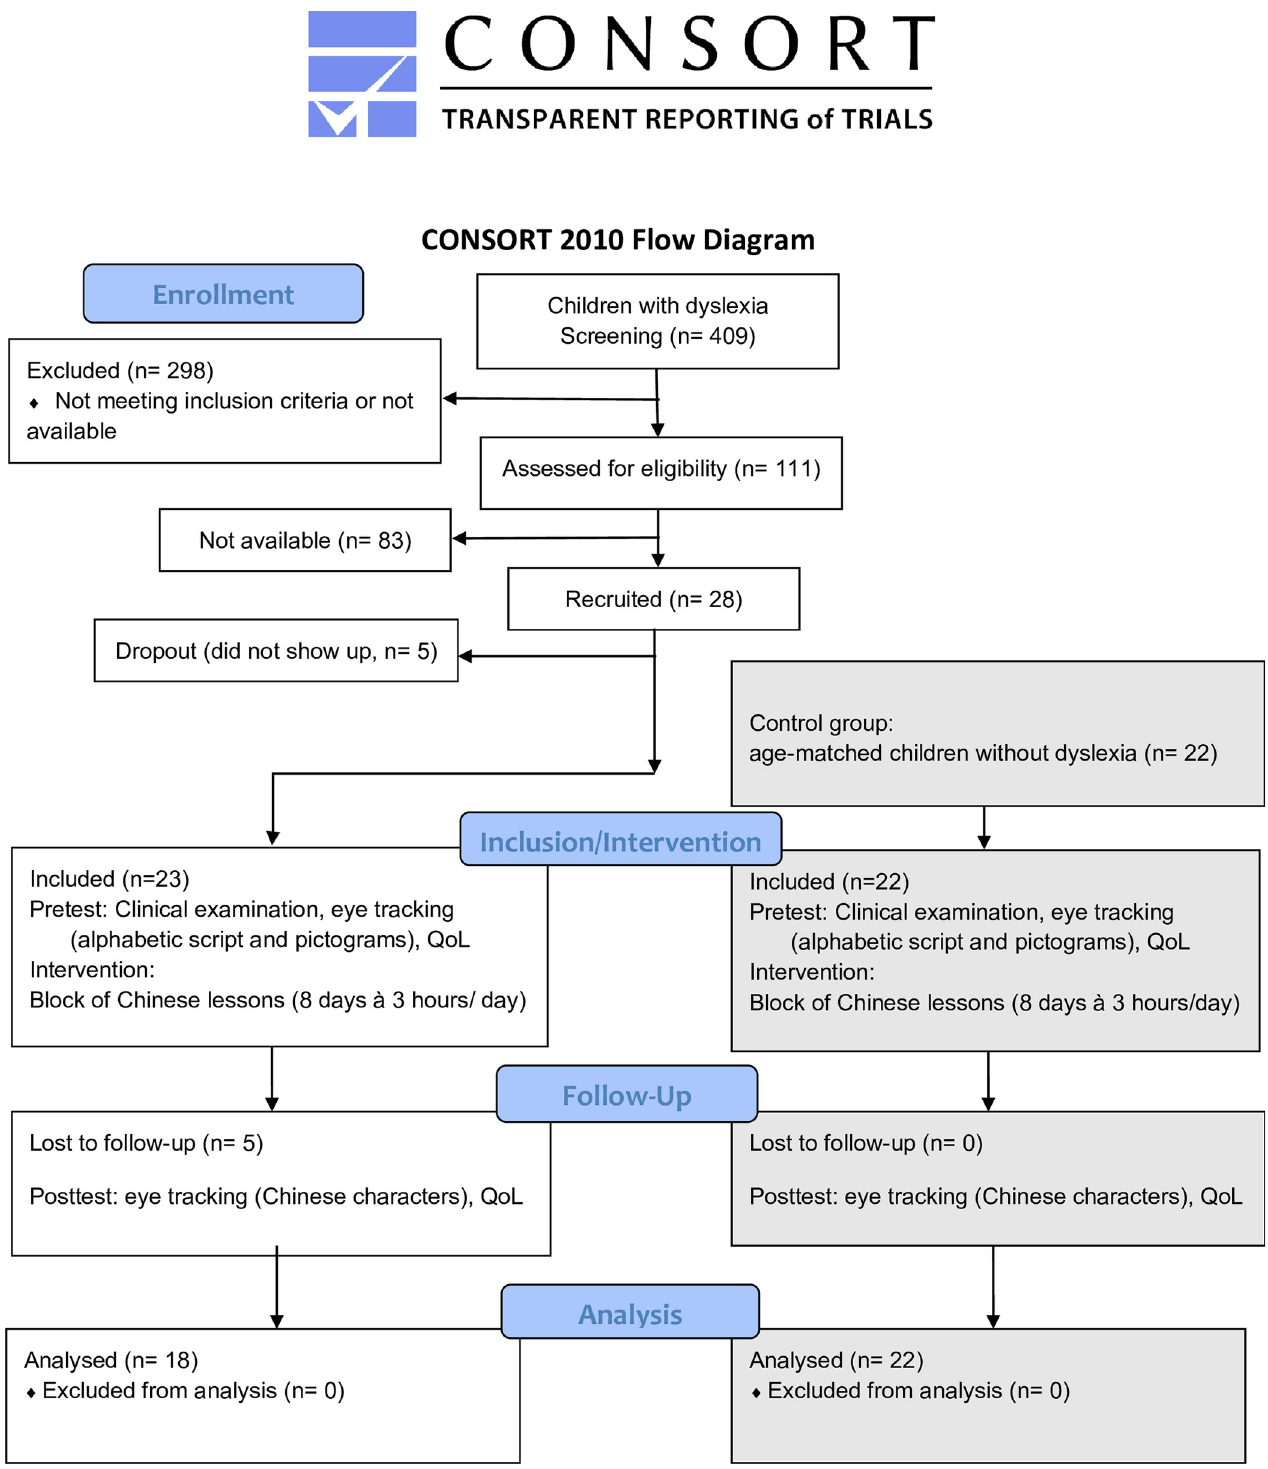
Fig 1. CONSORT flow diagram of the study. For details see the following text.